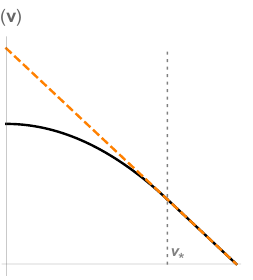
Figure 1 . Illustration of a typical velocity dependent Lyapunov exponent in strongly coupled theories. At small velocities, the function is quadratic, which corresponds to a di(cid:11)usive spreading of operators. The VDLE saturates the bound (1.8) from some (cid:12)nite, order one critical velocity v giving a ballistic butter(cid:13)y front with maximal Lyapunov